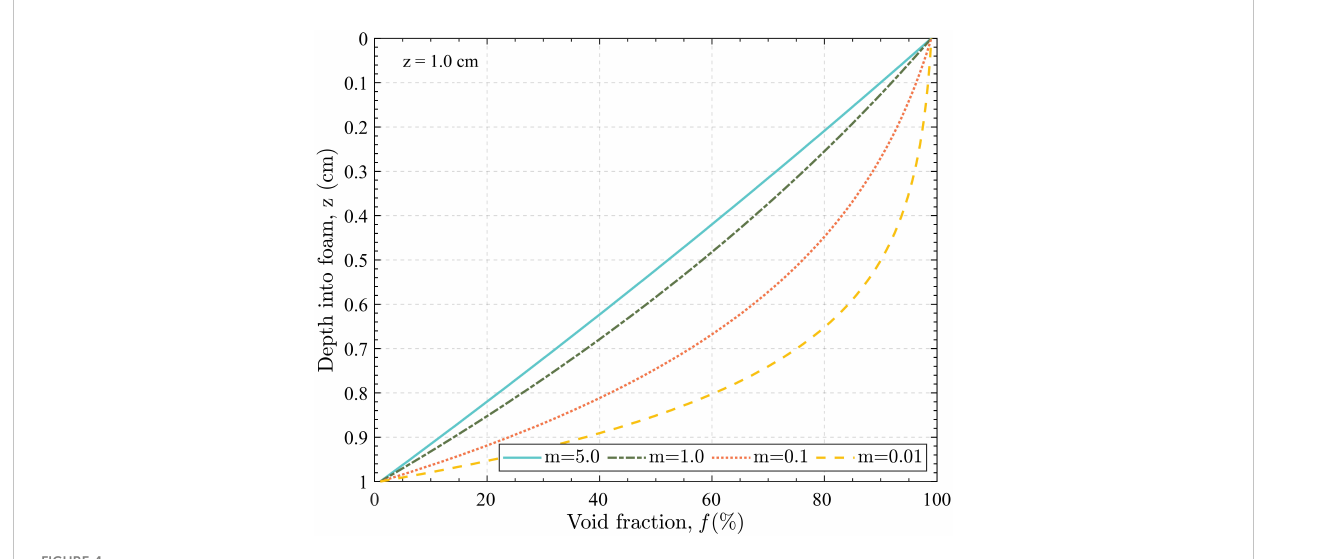
FIGURE 4 Void fraction pro fi le f ( z ) in foam layer with thickness z = 1